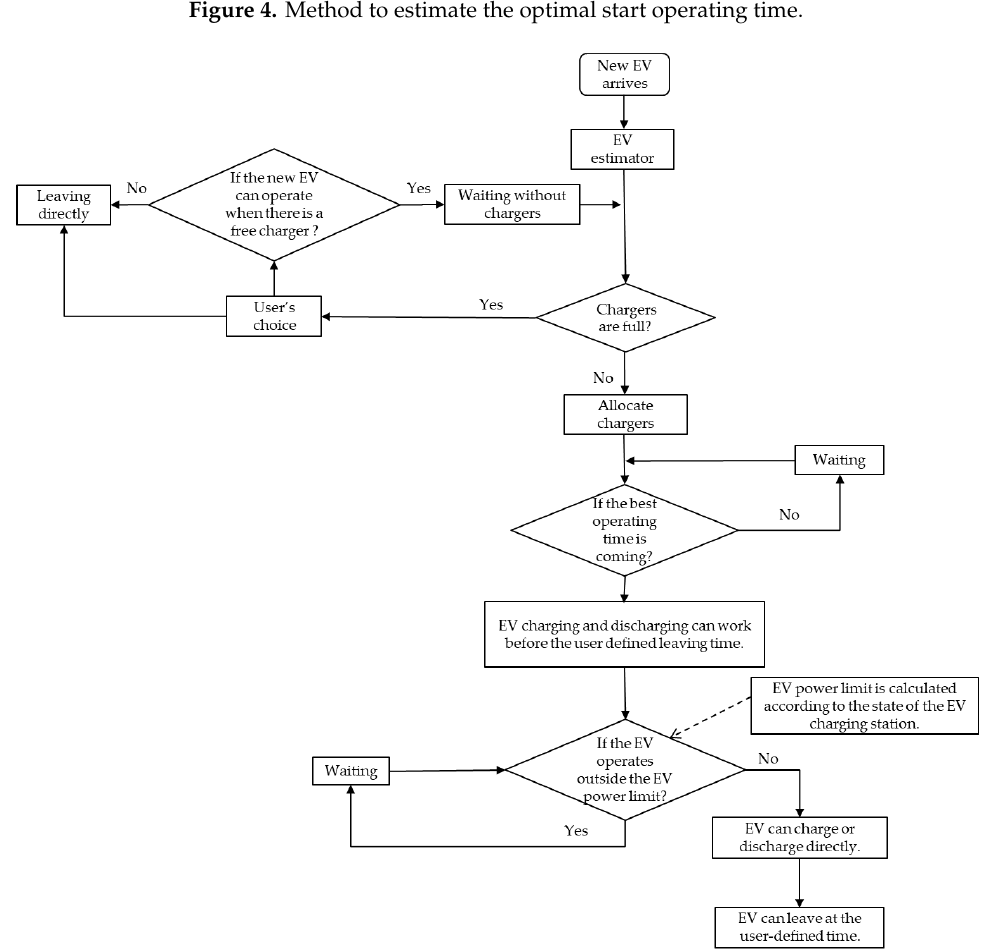
Figure 5. Flow chart of searching peak and valley algorithm (SPVA).